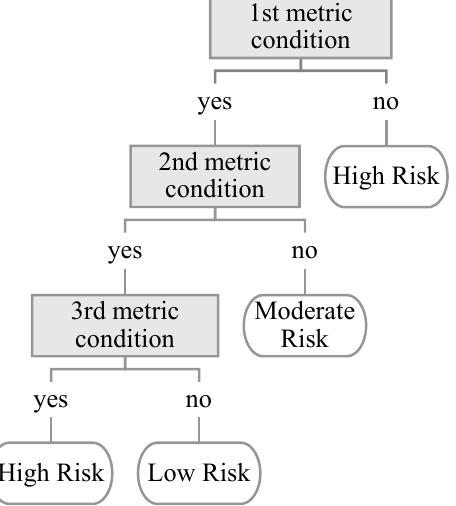
Figure 5. Decision Tree intelligent risk assessment.